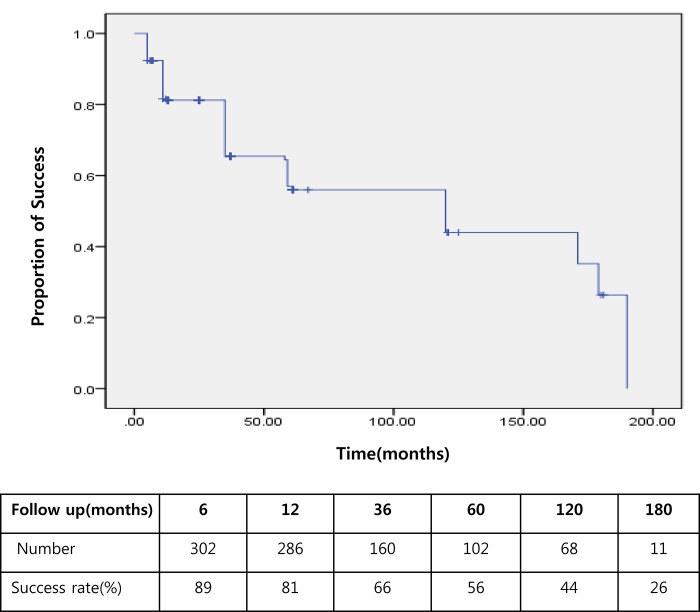
Kaplan-Meier estimates of the cumulative probability of valve success for AGV implantation.The success rate for patients with refractory glaucoma who had undergone AGV implantation was decreased with time. Percent of success cases and number of eyes during the follow-up period are shown in the box.